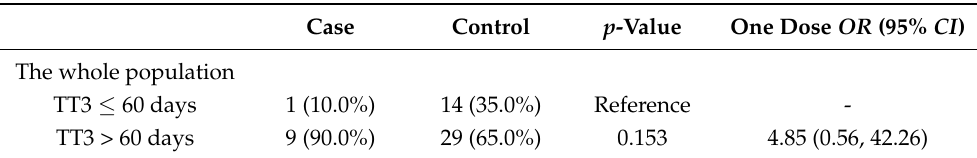
Table 3. The association between vaccination intervals and SARS-CoV-2 infection among those who received one vaccine dose.